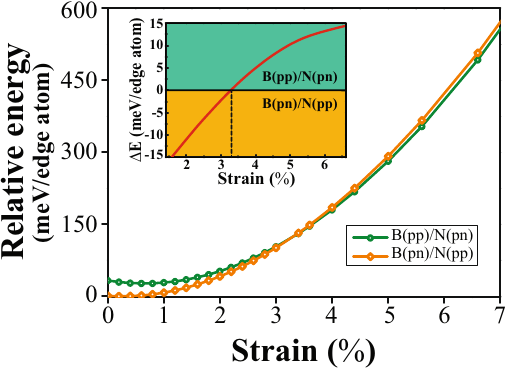
Figure 6. Energy change with uniaxial strain for magnetic zzBNNRs, suggesting the strain-induced transition of magnetic states from B(pn)/N(pp) to B(pp)/N(pn). The inset shows the energy difference between B(pn)/ N(pp) and B(pp)/N(pn) with uniaxial